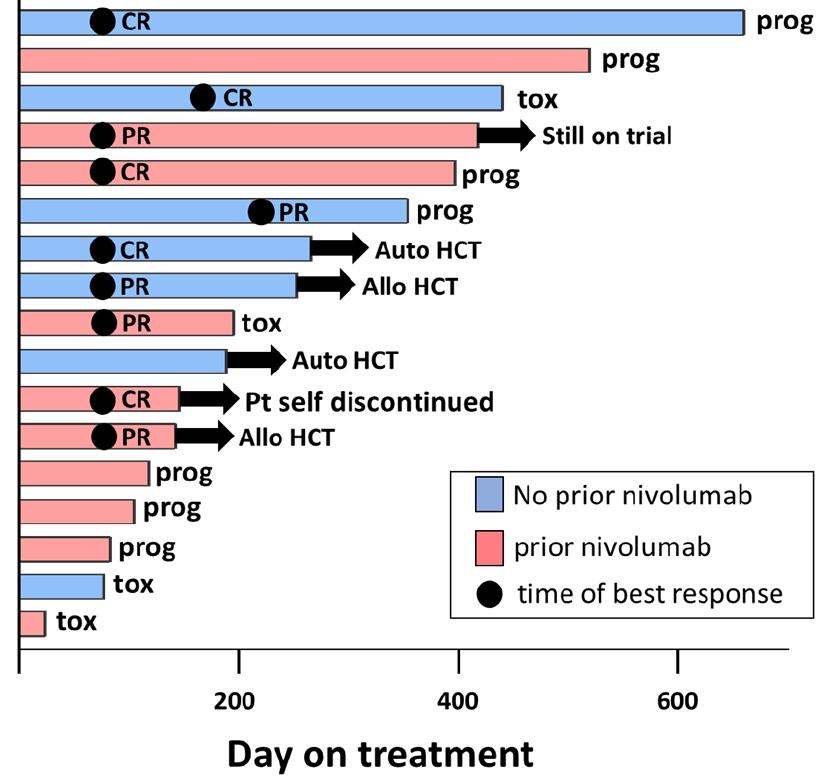
Figure 3. Swimmer’s plot of all patients enrolled in trial.